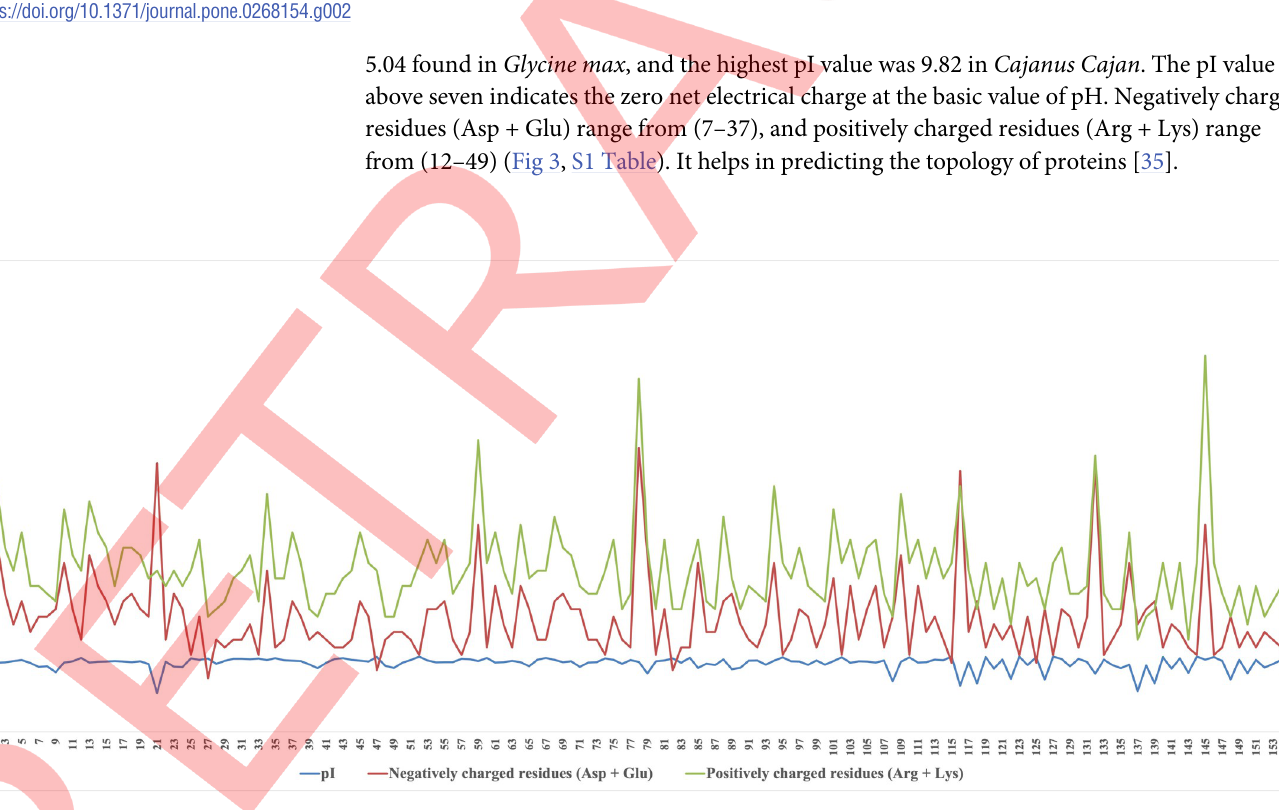
Fig 3. Physiochemical properties of the amino acid encoding a SWEET protein in 12 Fabaceae family comprises theoretical isoelectric point represented with blue color, negatively charged residues (Asp + Glu) coded with red color, positively charged residues (Arg + Lys) coded with green color.